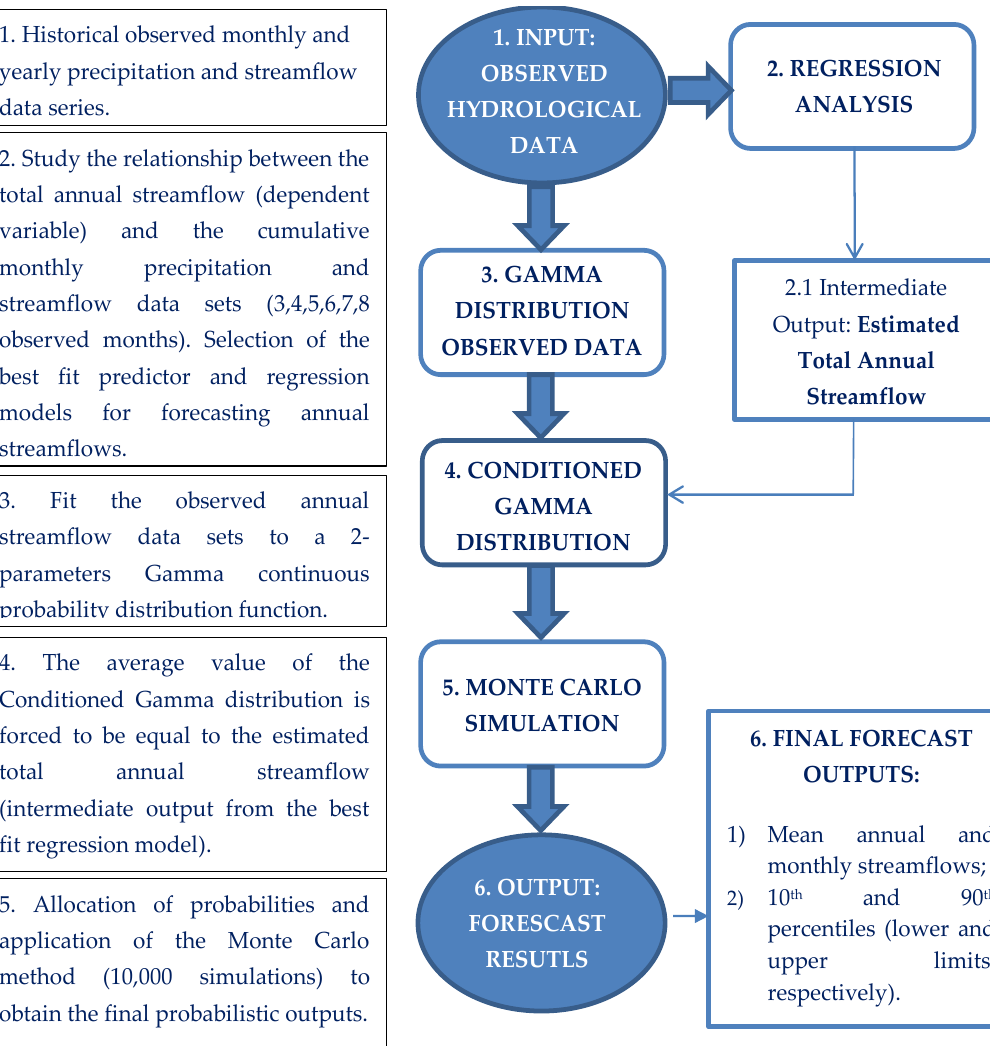
Figure 1. Flowchart of the methodology.